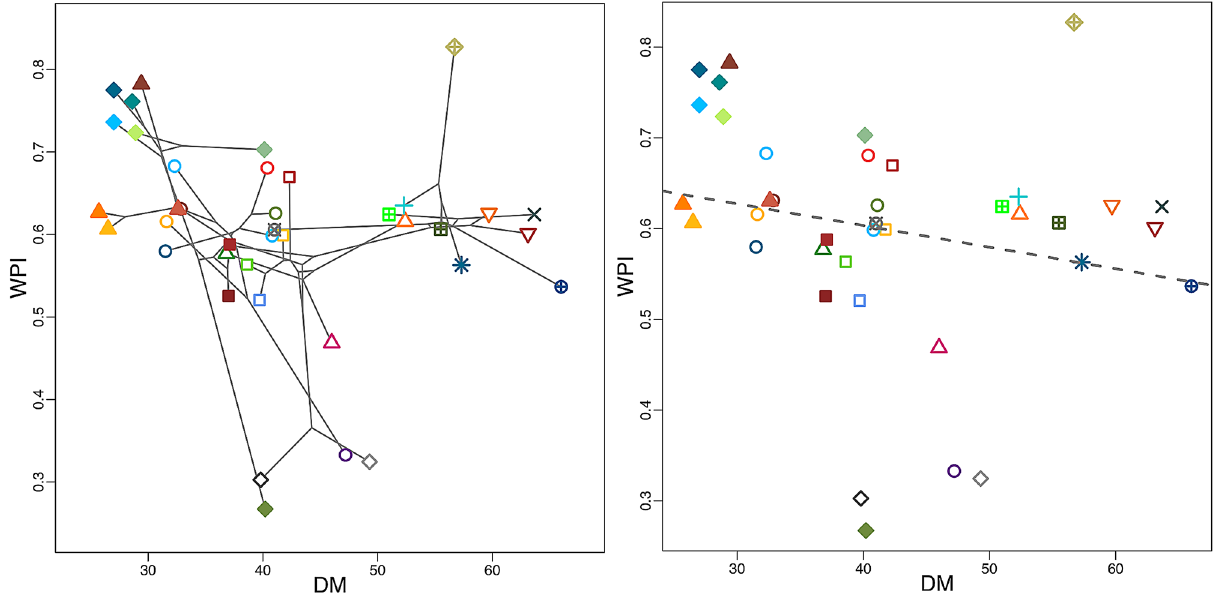
Figure 2. Phylomorphospace (left) and estimated PGLS regression describing the evolutionary association between the weighed pigmentation index (WPI) and the number of dorsal marks (DM) across evolutionary units within Eurasian vipers. See Fig. 1 for names of evolutionary unit